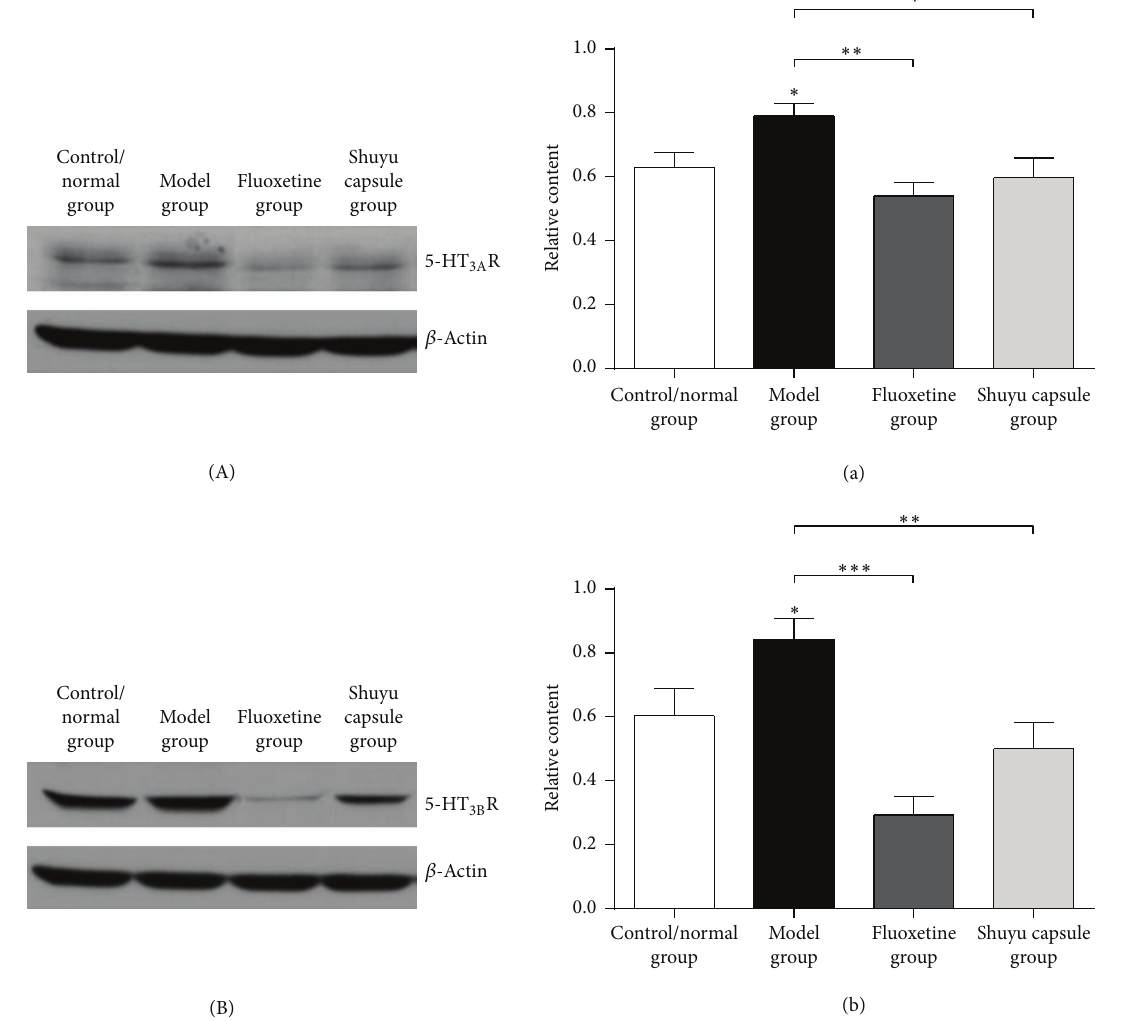
Figure 4: Western blot and primary hippocampal neuron analysis. The following drug serums were extracted and employed to treat primary hippocampal neurons: control/normal group, model group, positive-control fluoxetine group, and Shuyu capsule group. Both antibodies to R (A) and 5-HT R (B) were used to test protein levels in hippocampal neurons among the groups. A quantitative analysis ( 𝑛 = 6 ) of 5-HT 3A 3B the western blot results (a, b) was performed ( ∗ 𝑃 < 0.05 , ∗∗ 𝑃 < 0.01 , and ∗∗∗ 𝑃 < 0.001 ).